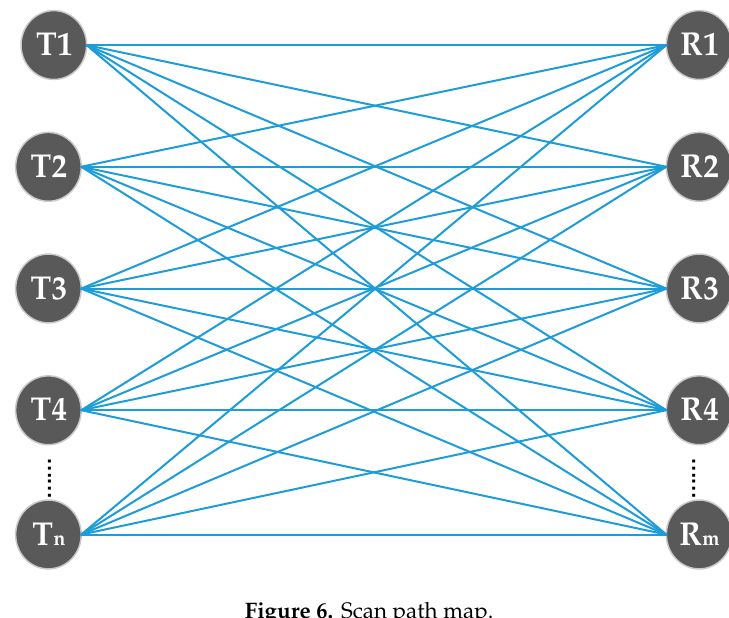
Figure 6. Scan path map.